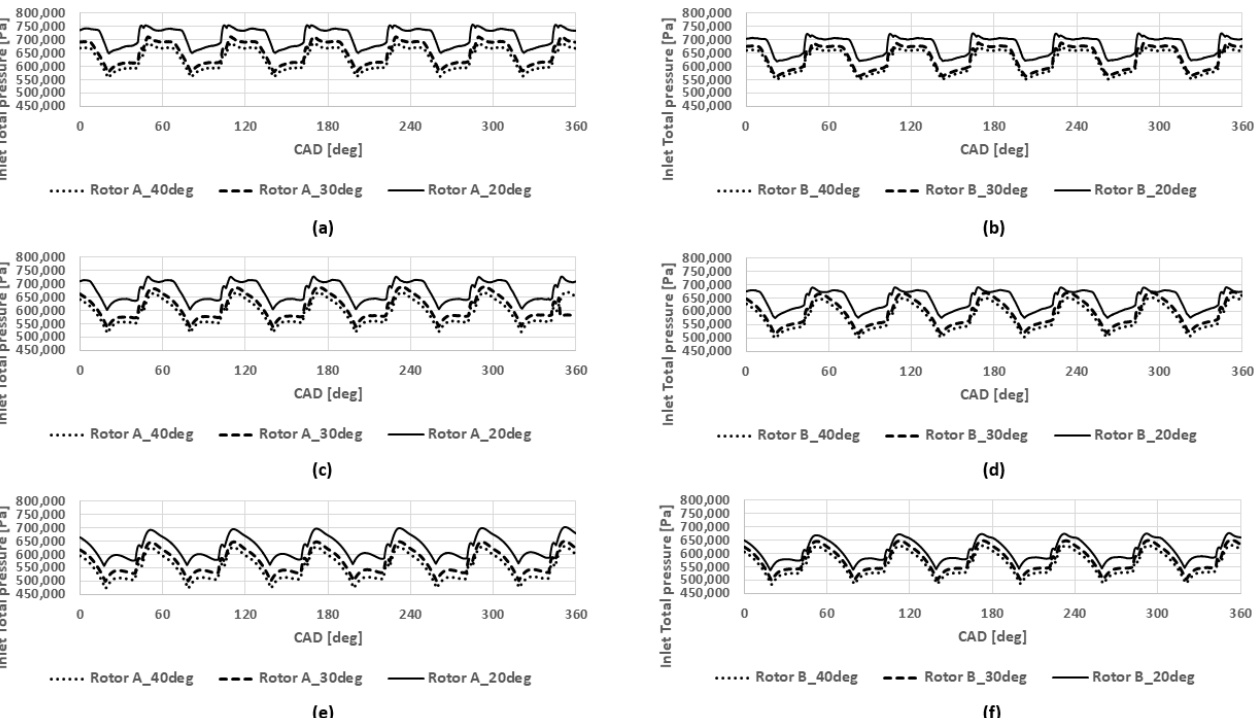
Figure 21. The area-averaged pressure changes at the inlet to the first-stage rotor during the single revolution of the crankshaft for three different turbine speeds, VTG vane positions and rotor geome- tries: ( a ) rotor A at 60,000 rpm, ( b ) rotor B at 60,000 rpm, ( c ) rotor A at 50,000 rpm, ( d ) rotor B at 50,000 rpm, ( e ) rotor A at 40,000 rpm, ( f ) rotor B at 40,000